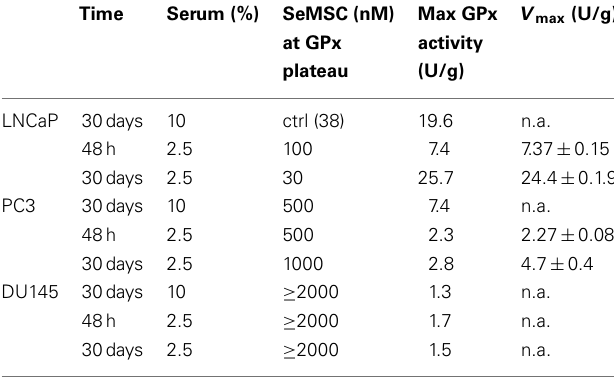
Table 2 | SeMSC concentrations at which GPx activity